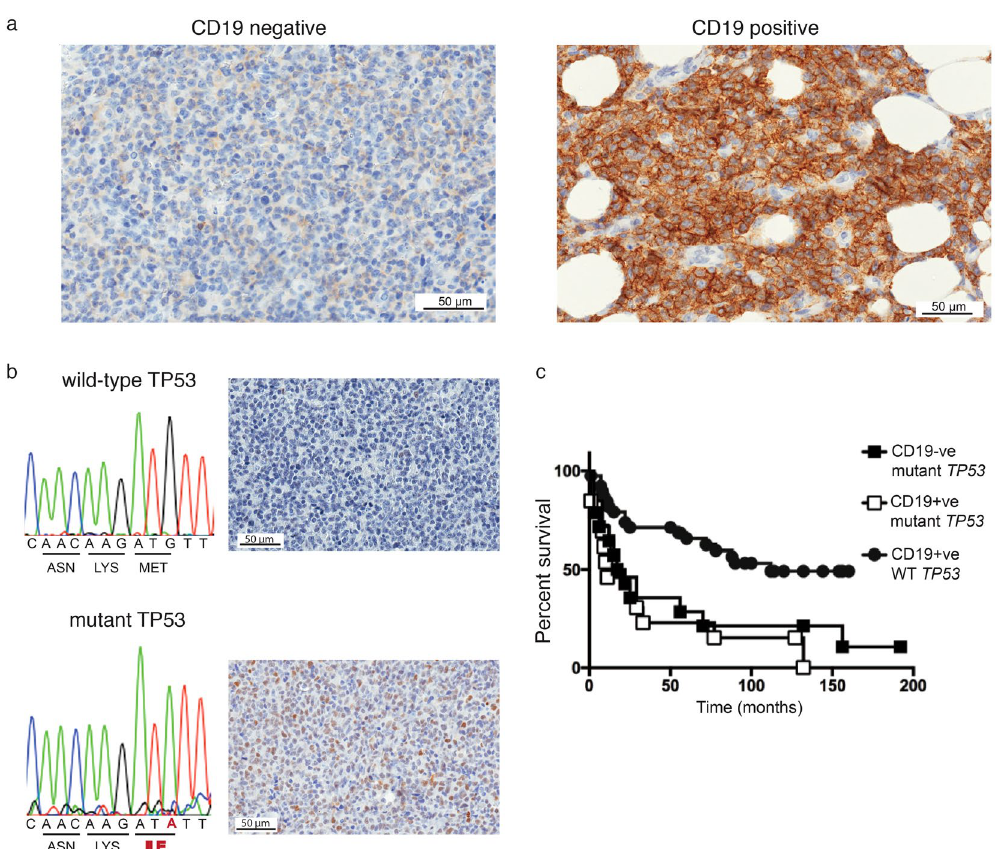
Figure 1. Tumor protein 53 mutations in CD19 negative DLBCL. ( a ) Left panel, CD19 negative lymphomas lacked CD19 staining using immunohistochemistry. Right panel, CD19 positive lymphomas showed strong CD19 staining. ( b ) Lymphomas were sequenced to identify TP53 mutations. Sequence analysis of a CD19 negative lymphoma with a M133I mutation is given in comparison to the wild-type TP53 sequence. Increased p53 by immunohistochemistry was used to predict lymphomas with TP53 mutations. The corresponding p53 immunohistochemistry staining for the lymphoma with the MI33I mutation and the lymphoma with wild-type TP53 are given. ( c ) Overall patient survival based on the CD19 and TP53 mutation statuses of lymphomas. TP53 mutations were identified by gene sequencing of tumor DNA and predicted by TP53 immunohistochemistry. WT, wild-type p53; TP53, tumor protein 53; − ve, negative; + ve, positive. p = 0.0003 (overall survival comparison between those with TP53 mutant and wild-type TP53